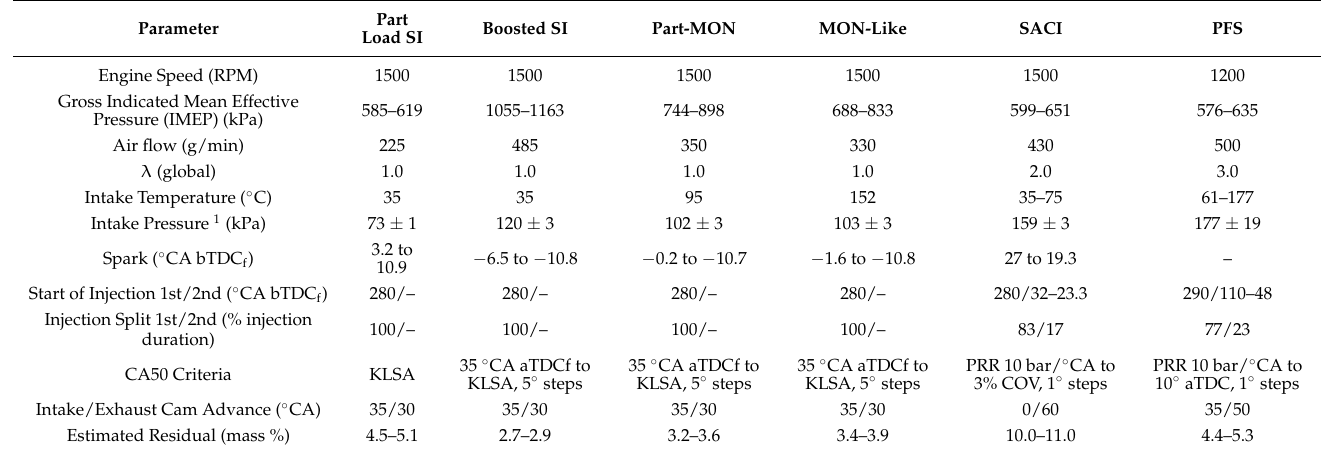
Table 2. Engine Operating